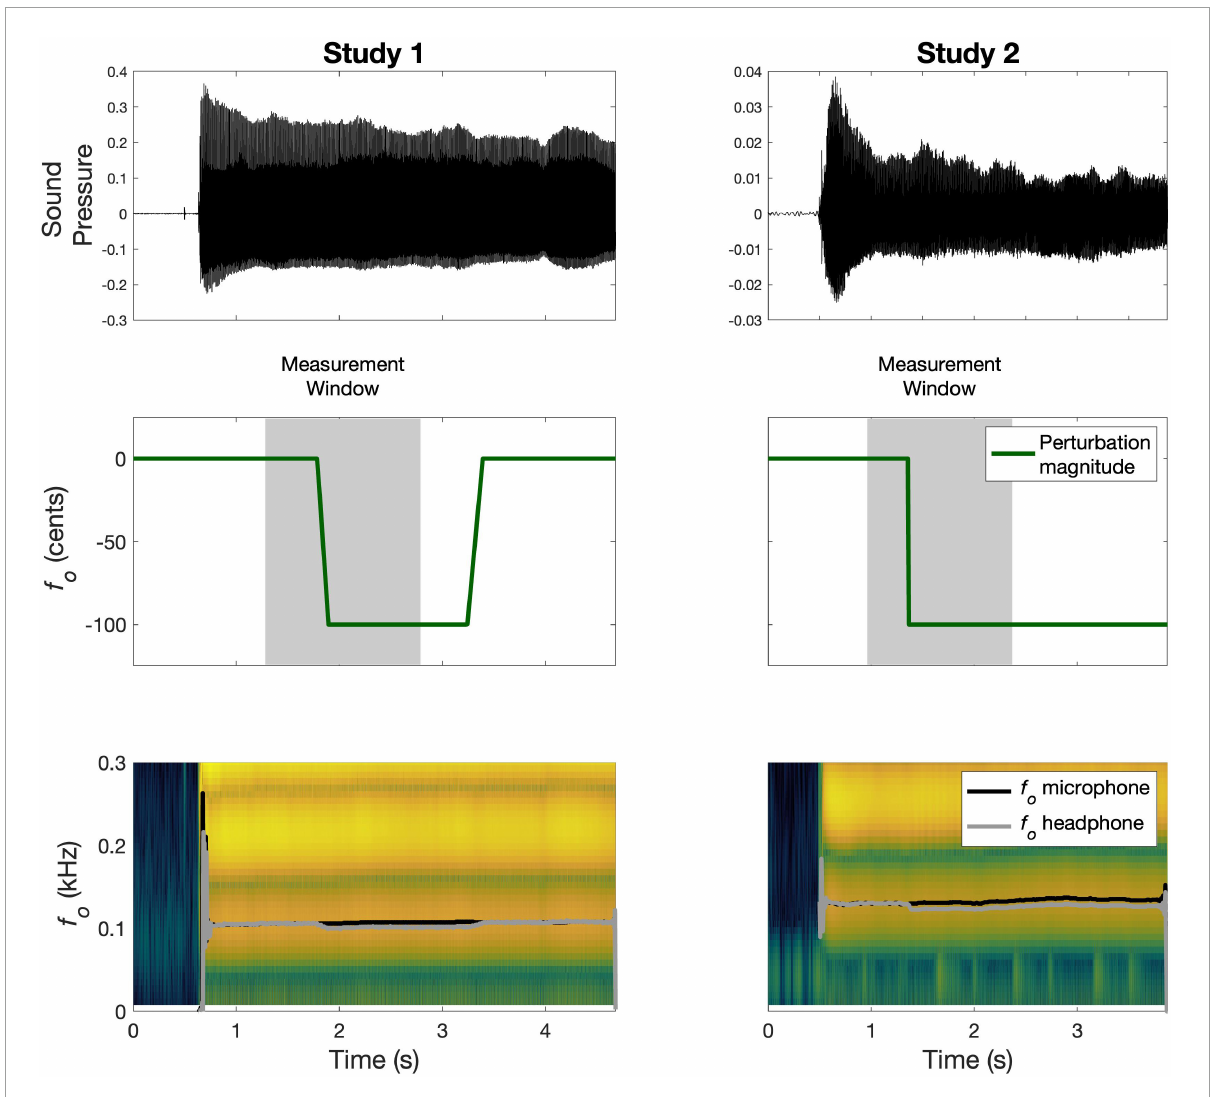
FIGURE1 Schematic of sample perturbed trials from Study 1 and Study 2. The top panel shows the recorded microphone signal; the middle panel illustrates the time-course of the perturbation magnitude in green along with the corresponding measurement window in gray; the bottom panel shows the spectrogram for the microphone signal with the measured f o traces overlaid in black (microphone) and gray